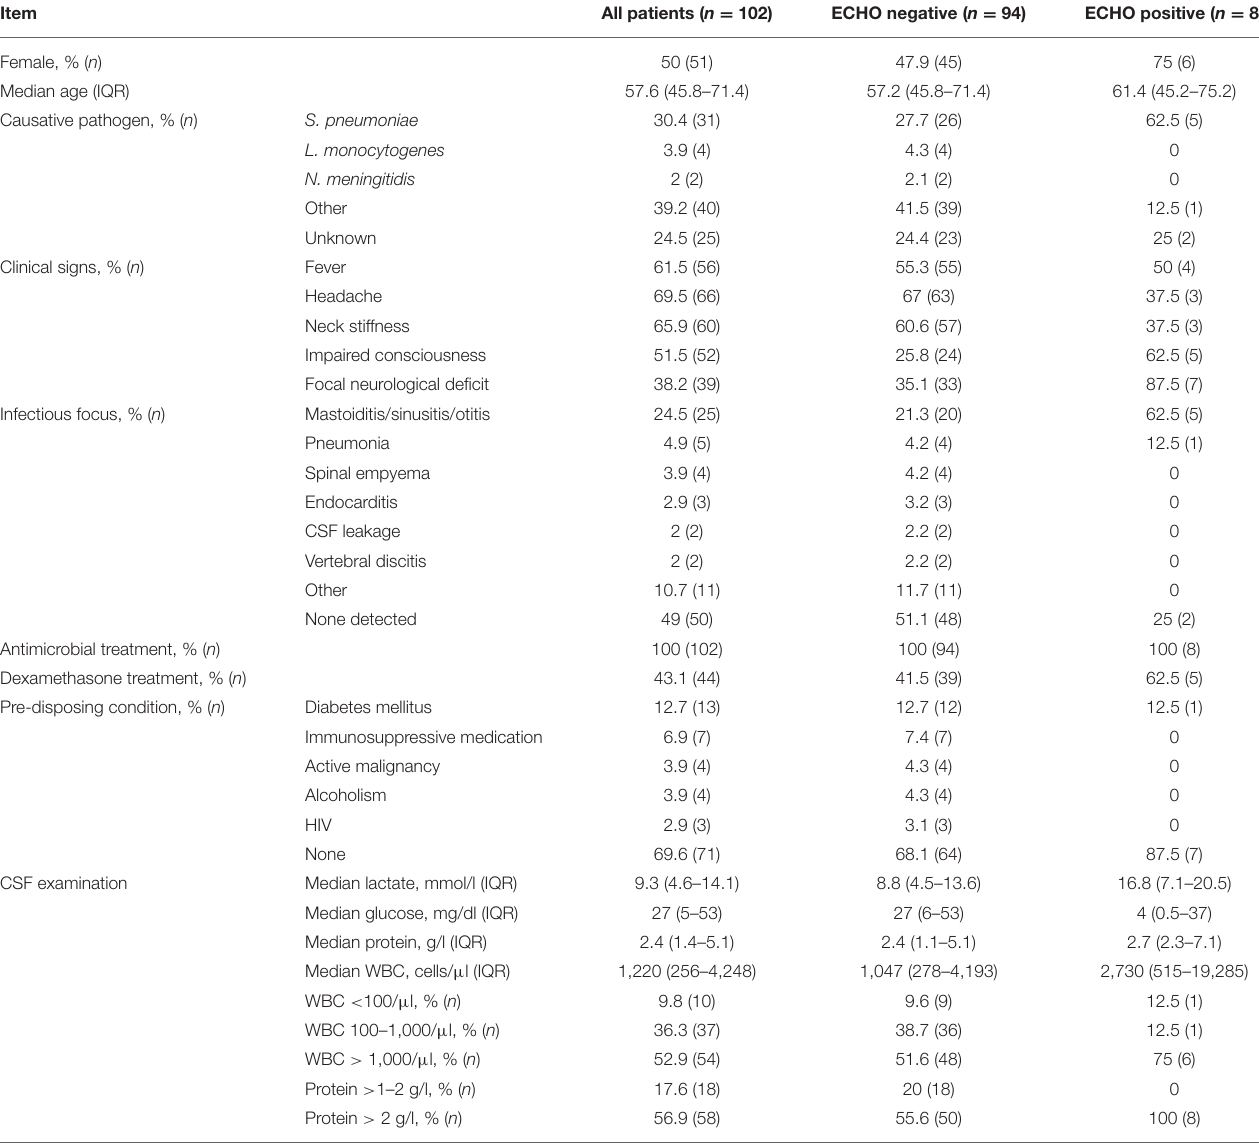
TABLE 1 | Clinical baseline